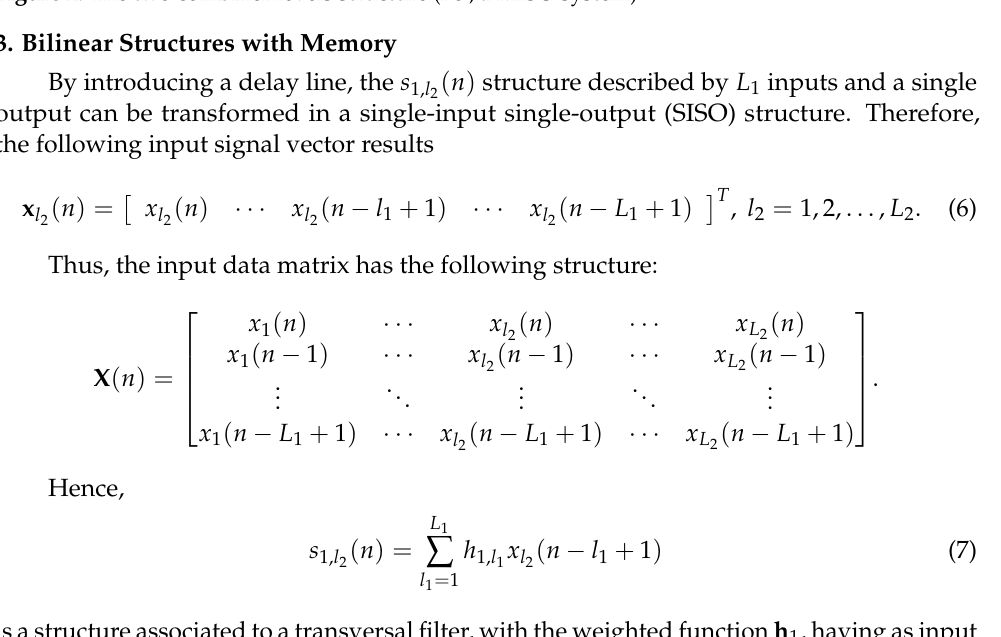
Figure 2. The two combiner levels structure (i.e., a MISO